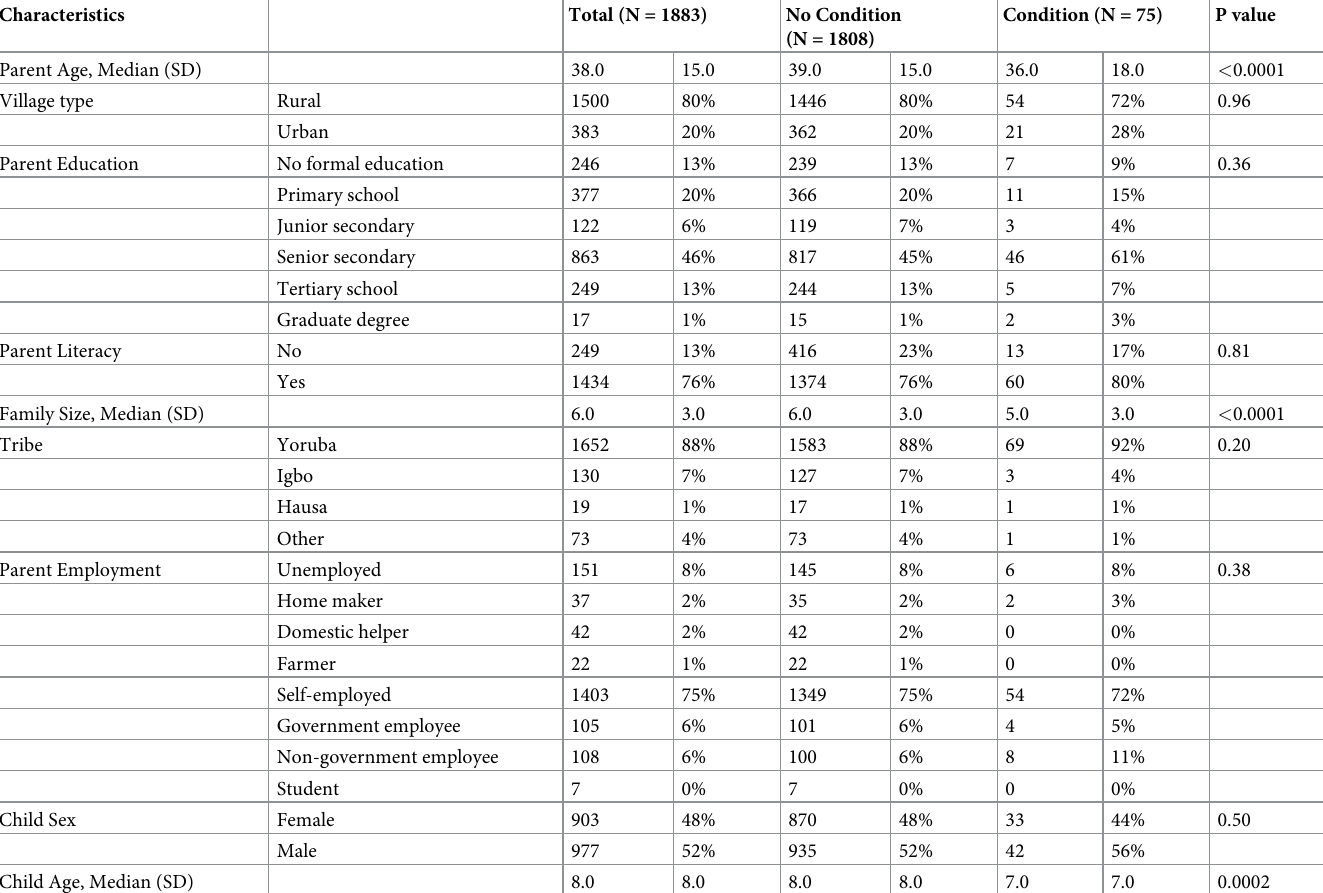
Table 2. Characteristics associated with childhood surgical conditions (Any reported condition).